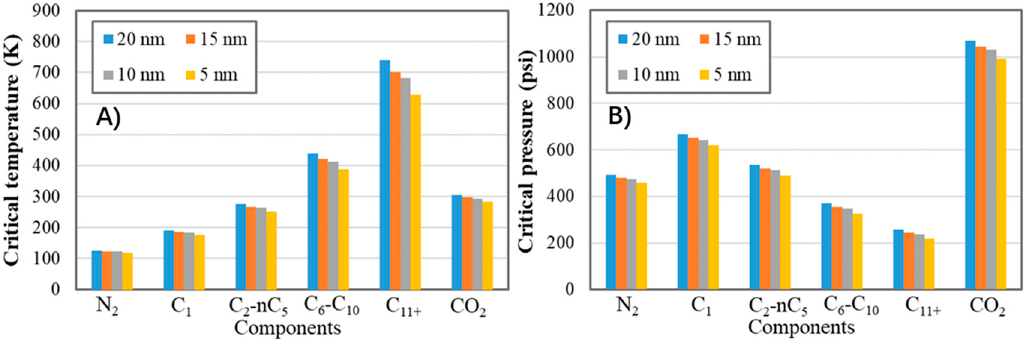
Figure 2. The critical properties of different components under different sizes. ( a ) Critical temperatures; ( b ) Critical pressure.